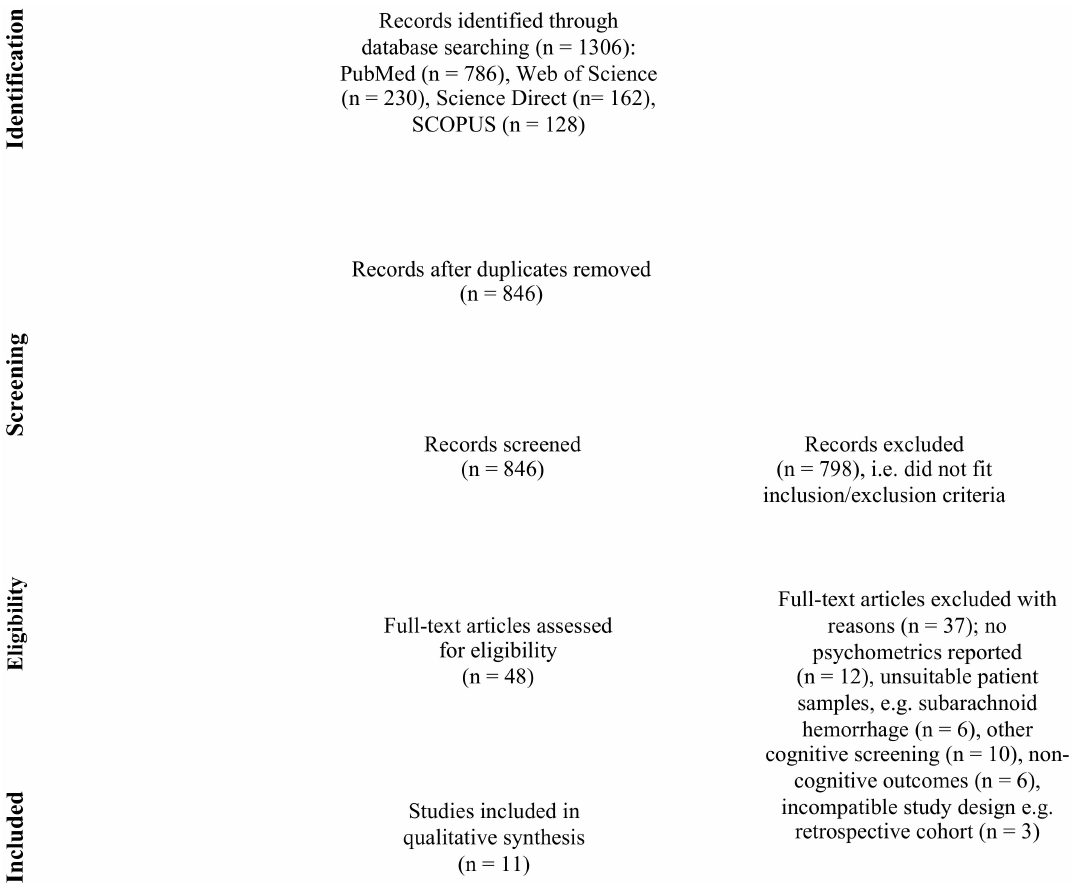
Figure 1. PRISMA (Preferred Reporting Items for Systematic Reviews and Meta-Analyses) flowchart for screening tests for post-stroke cognitive impairments in